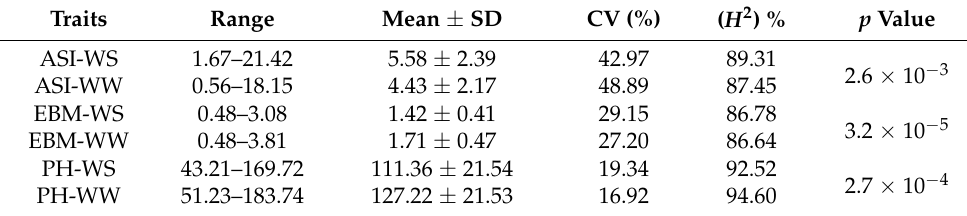
Figure 2. Frequency distributions of ASI, EBM, and PH under two water treatments. Table 1. Descriptive statistics and heritability estimate for the traits of association panel.